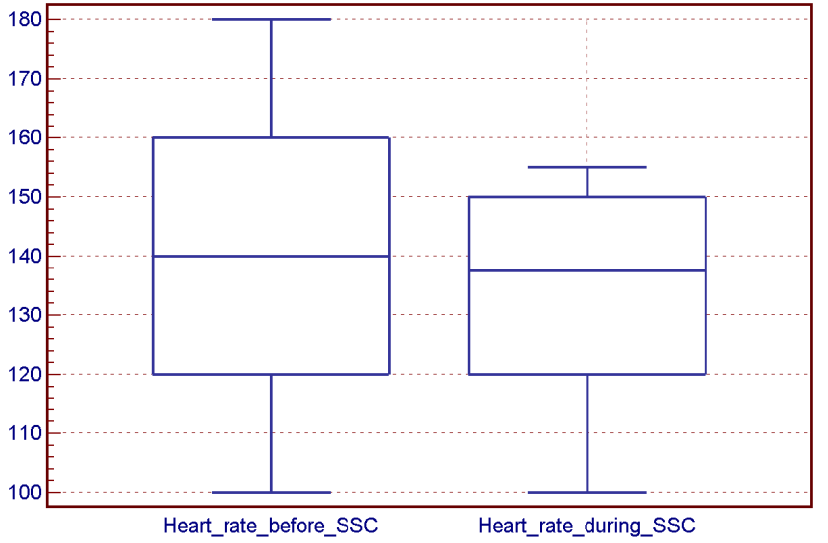
Figure 2. Infants’ heart rate before (median 140 beats per minute, range 100–180) and during an SSC session (median 137 beats per minute, range 100 – 155) ( p = 0.22).